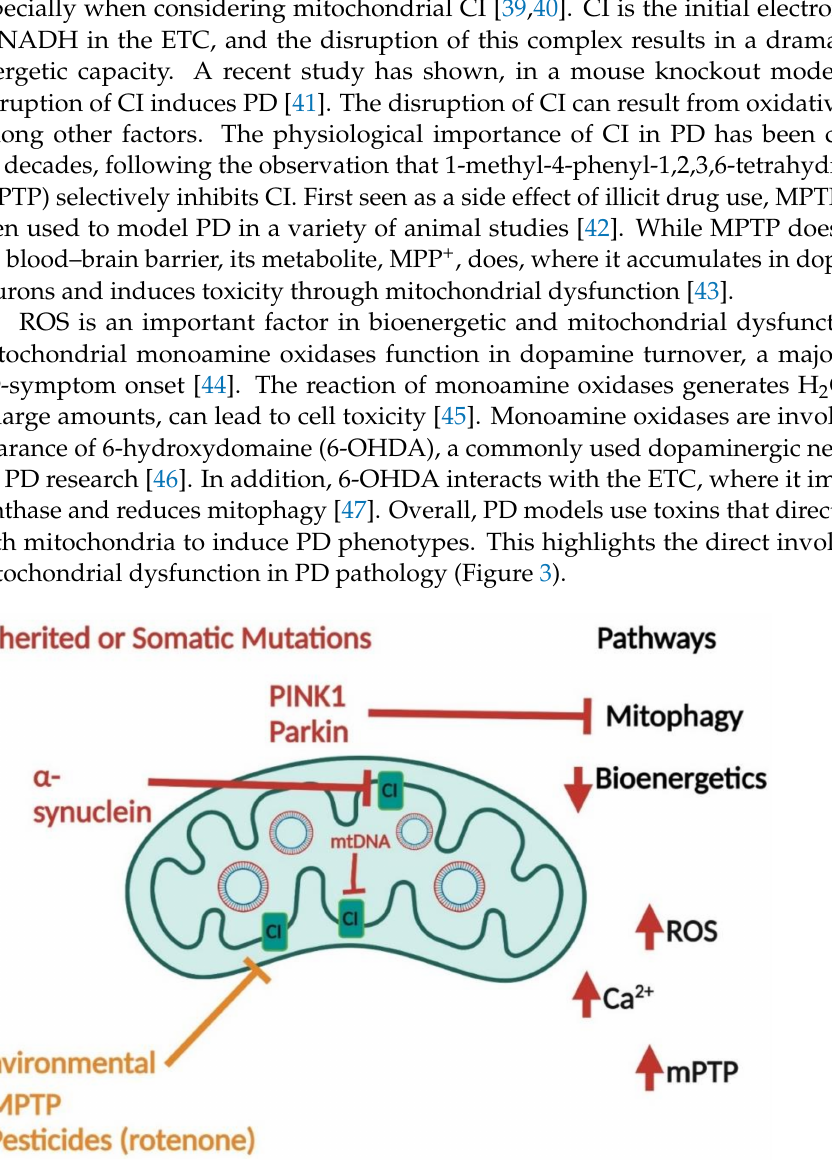
Figure 3. Mitochondrial Dysfunction in PD. Inherited mutations in genes encoding proteins for PINK1, Parkin, and α -synuclein affect mitochondrial function through the inhibition (red blunt arrow) of CI and/or mitophagy inhibition. Environmental factors, such as MPTP and pesticide rotenone, inhibit CI (orange blunt arrow). mtDNA (either inherited or somatic mutations) inhibit complex I (red blunt arroa). All factors lead to increased ROS, mitochondrial calcium, and the activation of the mitochondrial permeability transition pore (mPTP) with decreased bioenergetics and